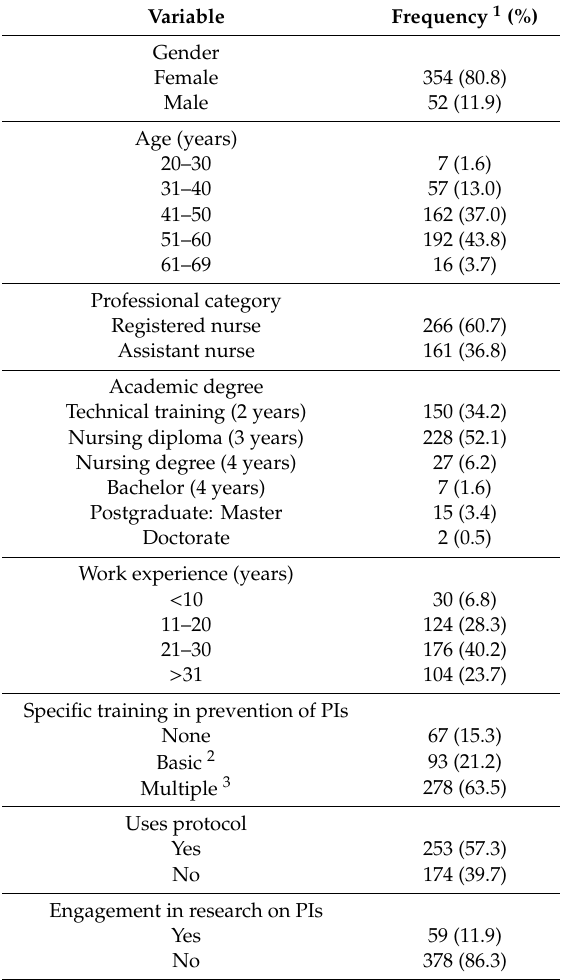
Table 1. Socio-demographic characteristics of the Registered Nurses and Assistant